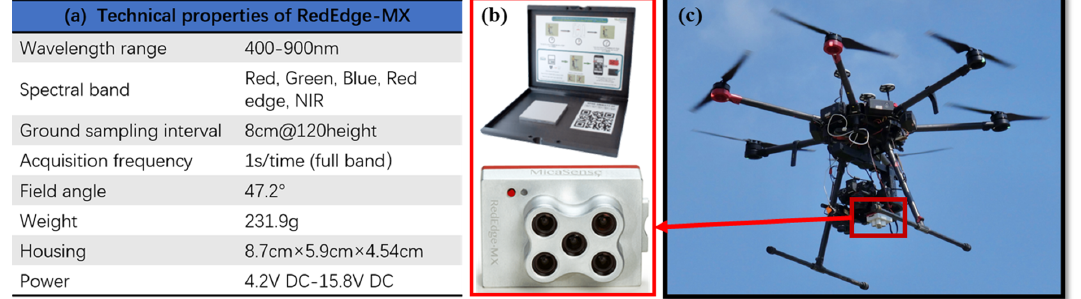
Figure 2. The parameters of the RedEdge ‐ MX multispectral camera ( a ). Corrected reflectivity panels and a RedEdge ‐ MX multispectral camera ( b ). The UAV (DJI ‐ M600Pro) is equipped with a RedEdge ‐ MX multispectral camera ( c ).